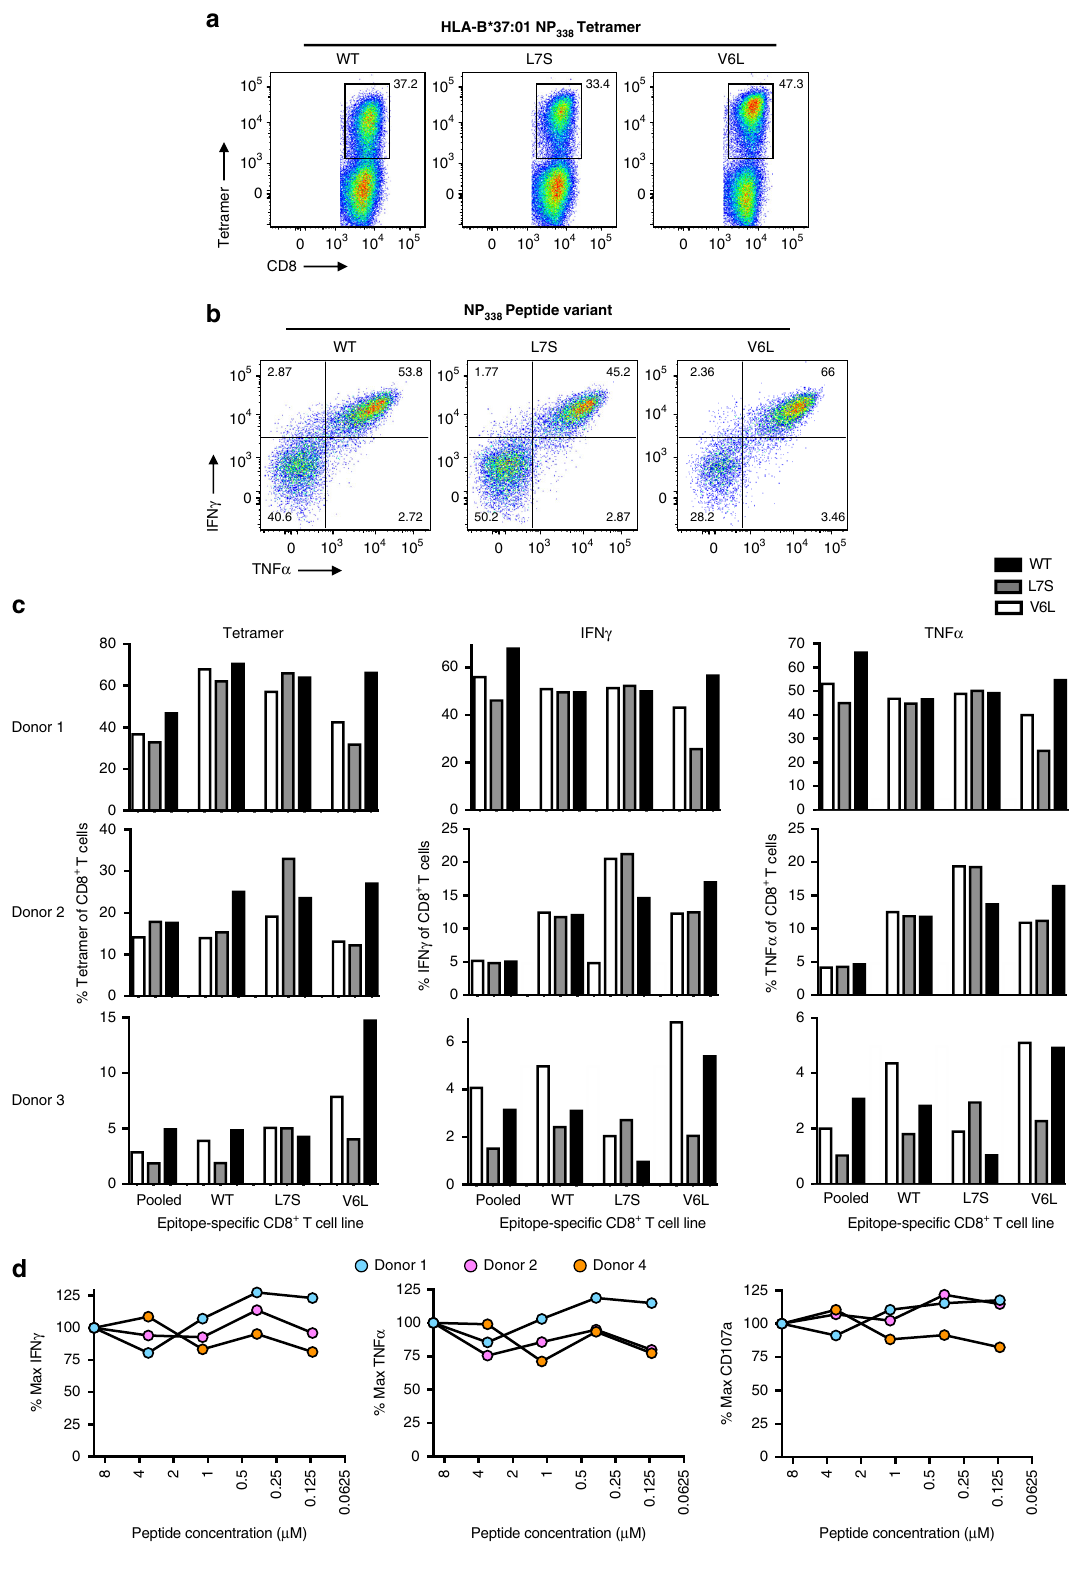
Glu and P9-Phe 49 , while P5-Arg acted as a secondary anchor residue (Fig. 3a, b). Superimposition of the HLA-B37-NP 338 binding cleft with either HLA-B37-NP 338 -V6L (Fig. 2c) or HLA- B37-NP 338 -L7S (Fig. 2d) revealed a similar conformation of the HLA-binding cleft (r.m.s.d. of 0.08 Å). In addition, the peptides adopted a similar conformation as the NP 338 peptide with an